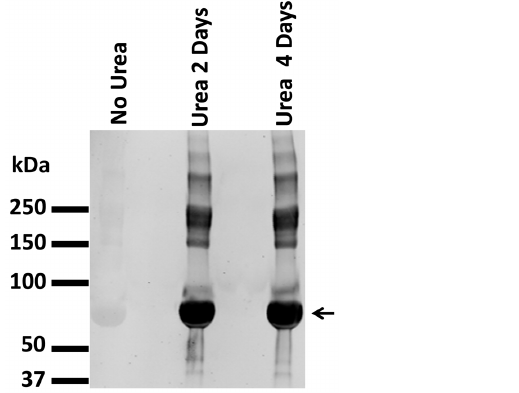
Figure 2. Specificity of anti-carbamyl-lysine antibody. Bovine serum albumin (BSA, 3 mg/ml, MP Biomedicals, Solon, OH) was incubated in 1M urea (in PBS) or PBS alone for two or four days. Following incubation, samples were dialyzed using 10,000 MWCO centrifugal filter devices (Microcon, Millipore, Billerica, MA). Samples were immunoblotted as described in Methods . Arrow indicates BSA monomer. Control sample used was incubated for four days in PBS alone.